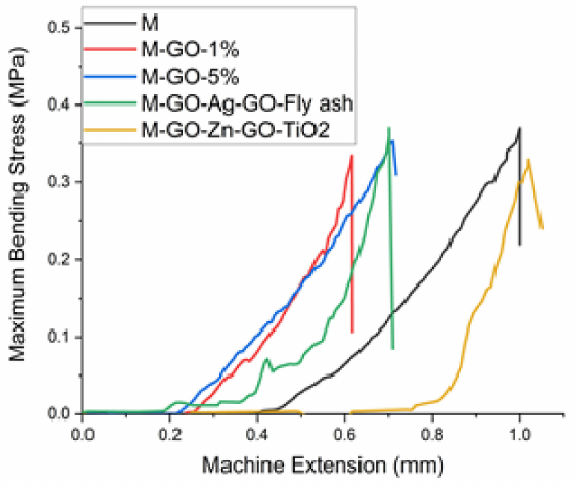
Figure 3. Stress–strain curves in the flexural test of the